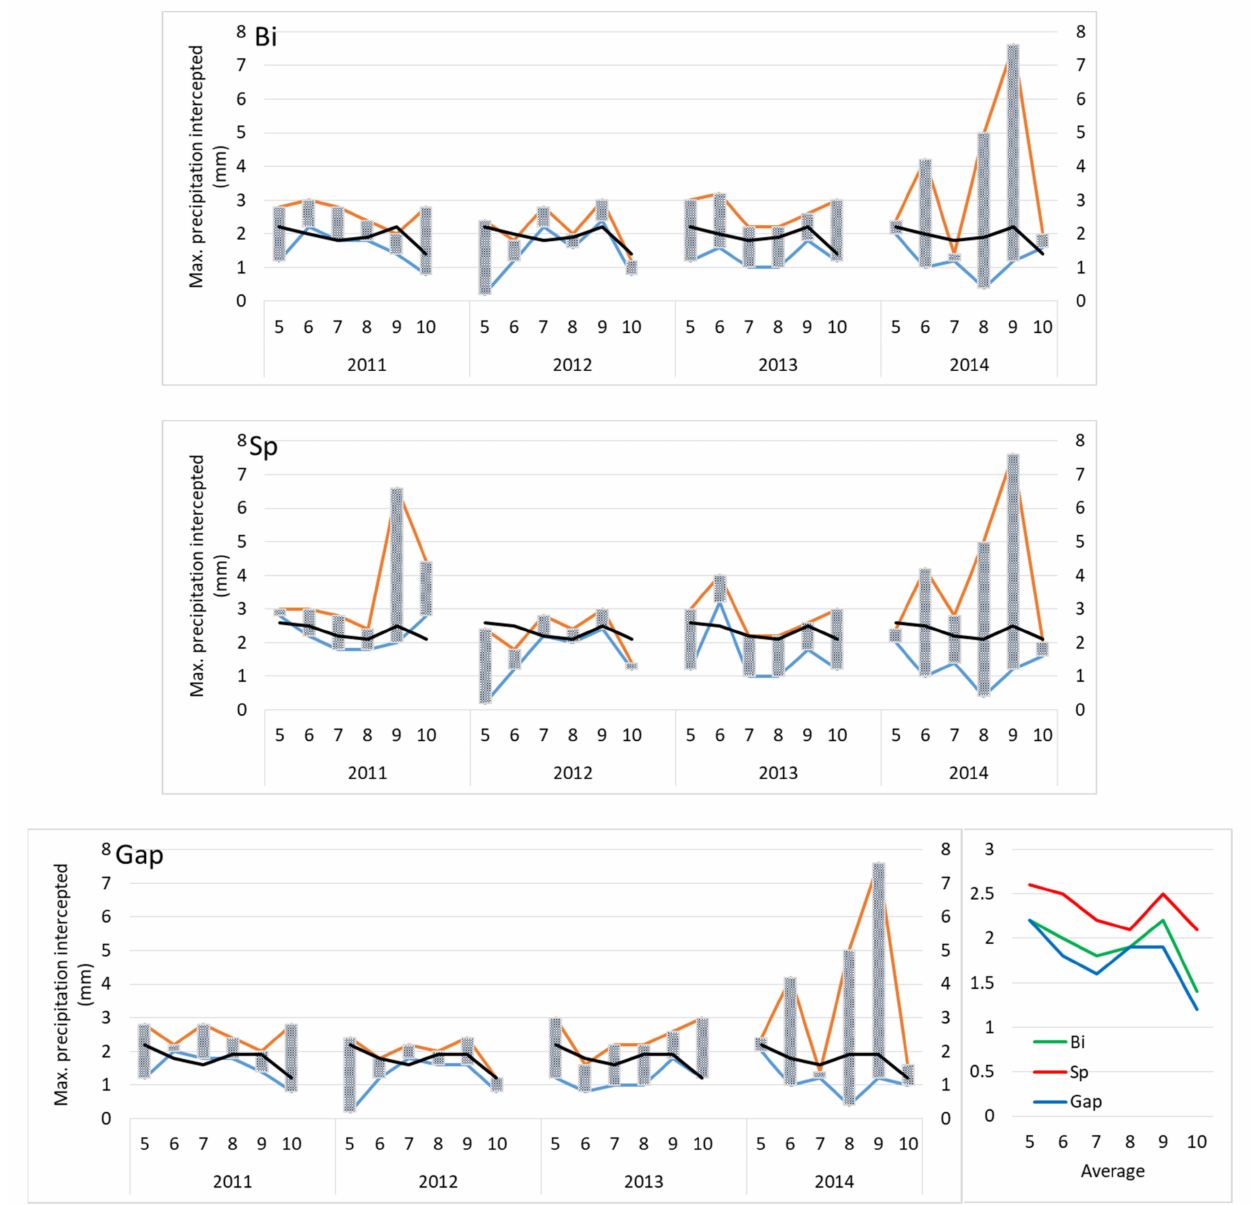
Figure 7. Intervals with interception capacities (maximal precipitation fully intercepted) according to treatment (Bi—birch, Sp—spruce, Gap), growing season, and month (left), and averages of maximal precipitation intercepted (right). Blue line—maximal precipitation subtotal of a fully intercepted event (with no response by the topsoil moisture); red line—next precipitation event in size (total mm); black line—average maximal interception for the